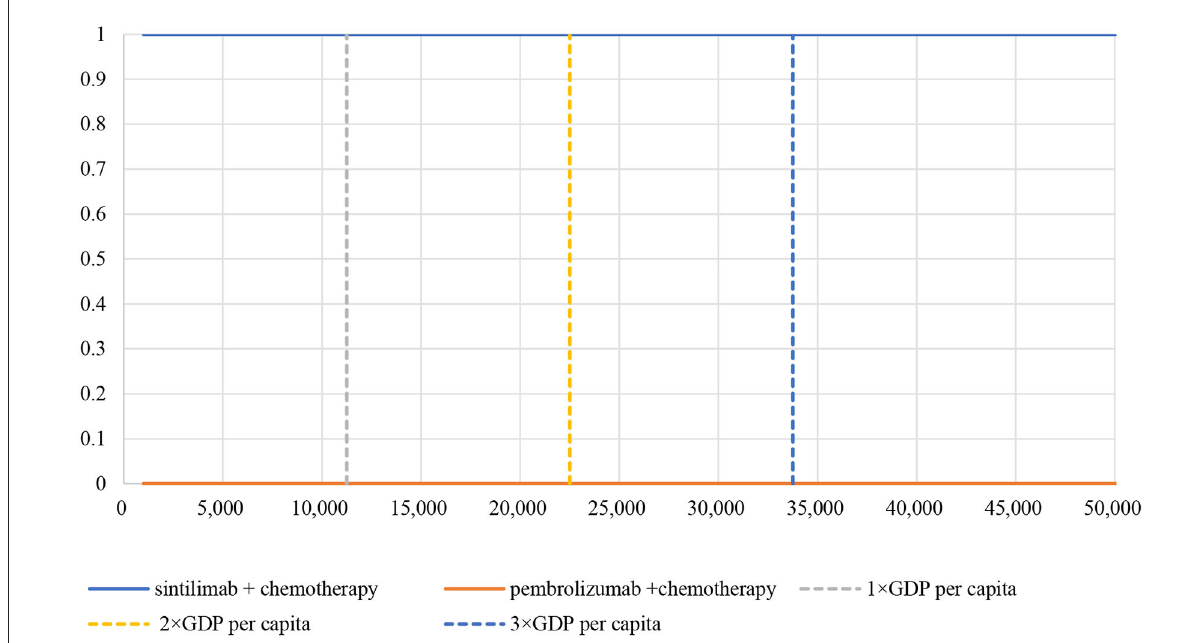
FIGURE5 Cost-effectiveness acceptability curve. WTP, willingness-to-pay; GDP, gross domestic product.